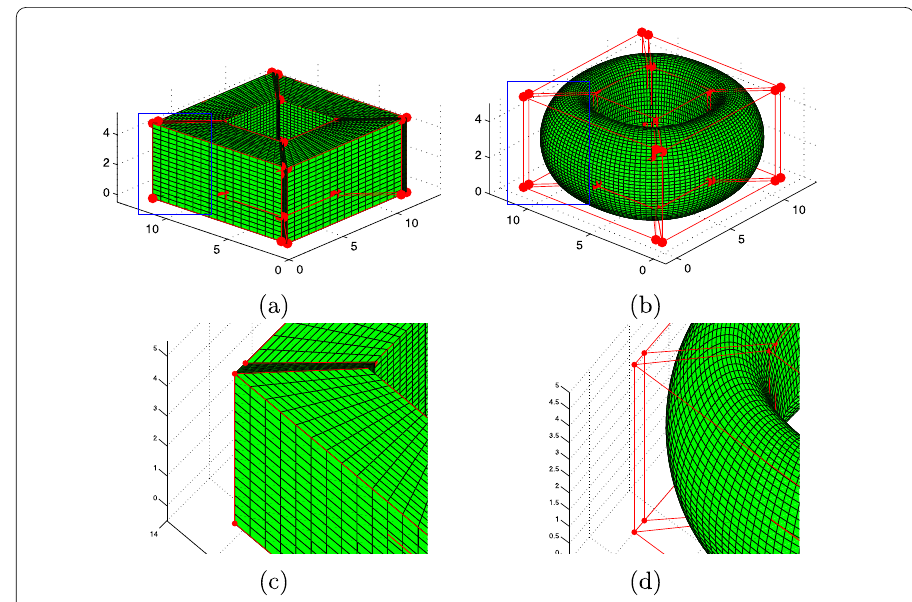
Figure 2 Surfaces generated by the tensor product schemes. ( c )–( d ) are the mirror images of the parts inside the blue rectangles of ( a )–( b ),